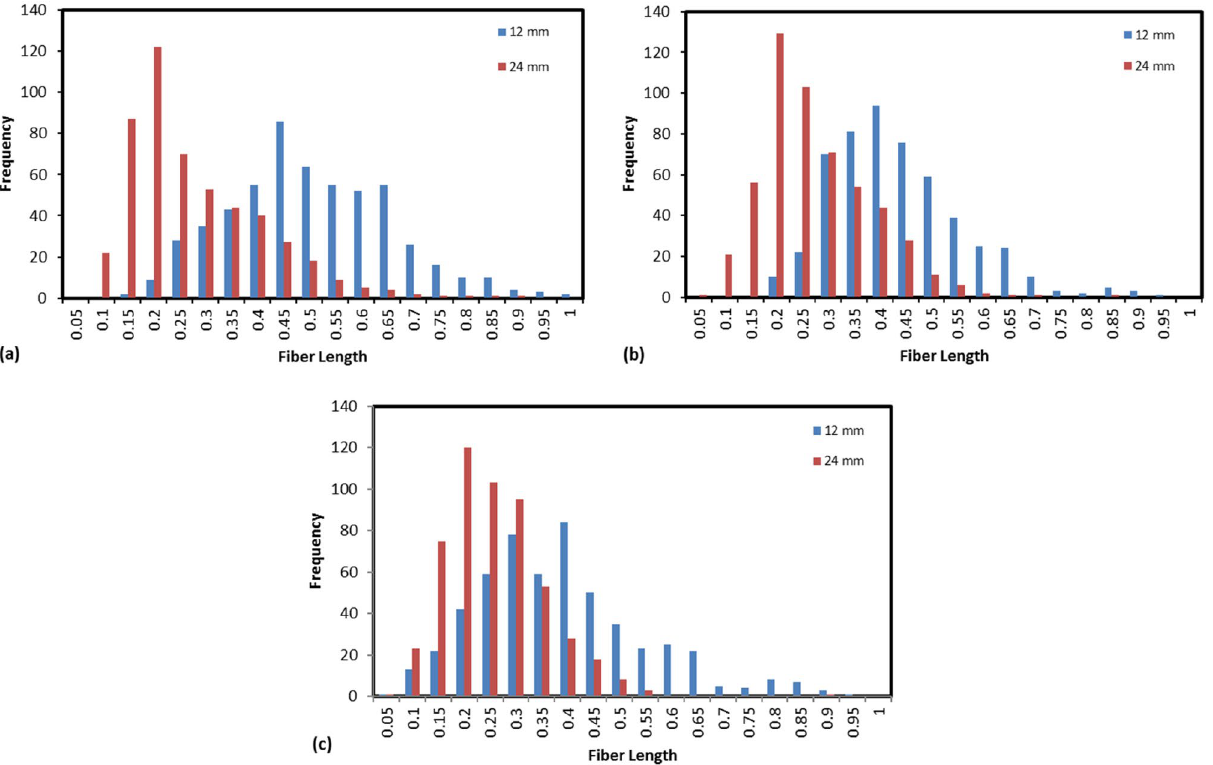
Figure 3. Fiber length distribution (FLD); ( a ) 10 wt%, ( b ) 20 wt%, and ( c ) 30 wt%.